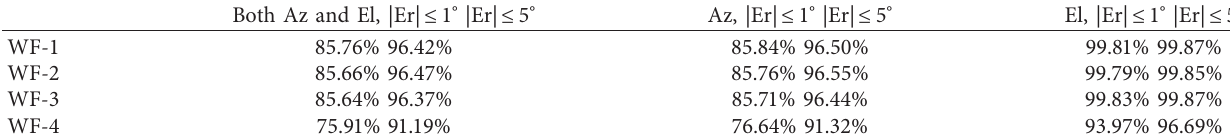
Table 6: Array-3 probability of AoA estimation using 1025 snapshots (10dB ≤ SNR ≤ 20dB).